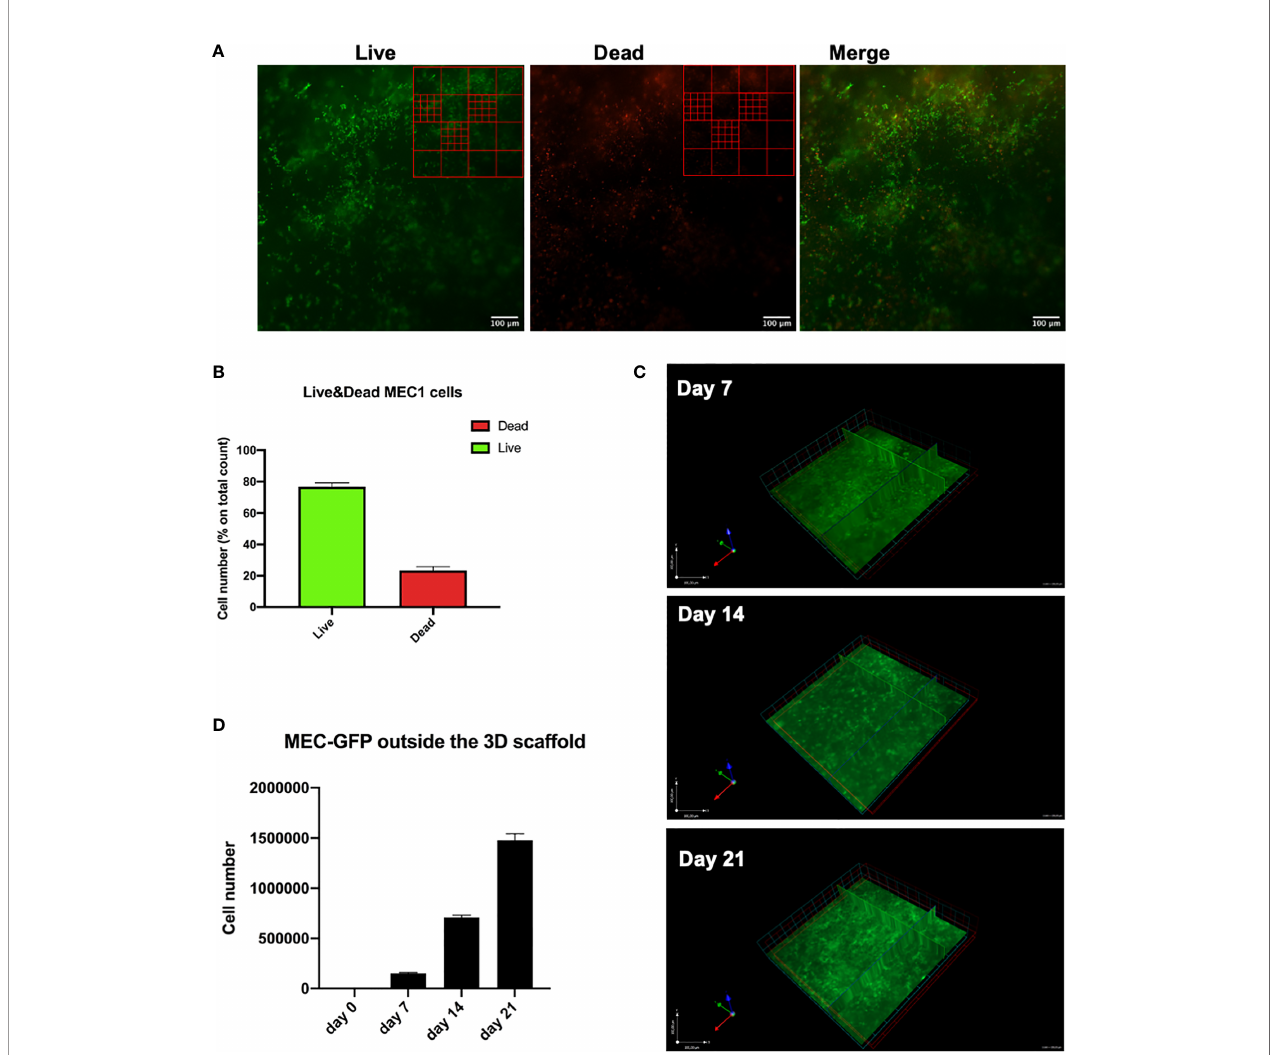
FIGURE 3 | CLL cells are viable and homogeneously distributed in the hydrogel matrix. MEC1 and/or MEC-GFP cell lines were used to de fi ne the optimal number of cells and hydrogel quantity to be printed. (A) Representative images of Live/Dead assay of 3D bioprinted MEC1 cell line acquired with Axio Observer Zeiss fl uorescent microscope. Green cells are alive cells; red cells are dead cells. An example of a grid scheme used to quantify alive and dead cells is shown on the top right of each image. (B) The graph shows quanti fi cation of alive (green column portion) and dead (red column portion) 3D bioprinted MEC1 cells. (C) Representative z-stack images of 3D bioprinted MEC-GFP cells in the scaffold overtime showing their distribution. Images were obtained with Axio Observer Zeiss fl uorescent microscope. (D) The graph shows quanti fi cation by cell count, at different time points (day 0-7-14-21), of viable MEC-GFP cells found outside the 3D bioprinted scaffold. Data are represented as mean ± SEM, n=3 (B) and n=5 (D)